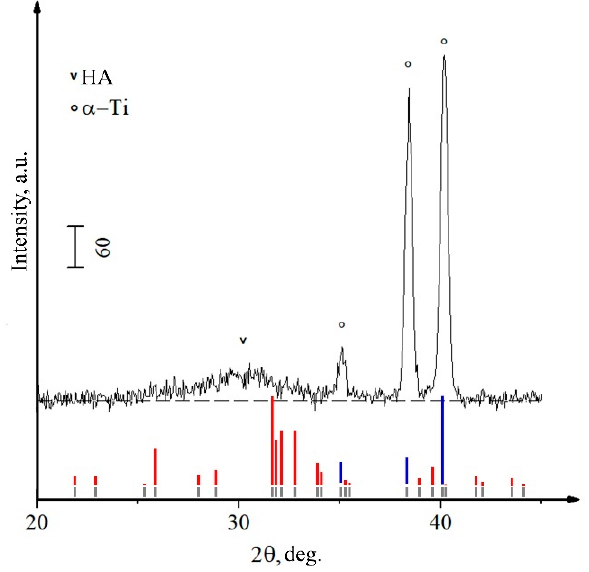
Figure 11. XRD pattern of the Zn containing CaP coating on the surface of NS Ti (red and gray lines represent Ti etalon XRD-patterns according to PDF-card no. 00-044-1294 HA etalon XRD-pattern according to PDF-card no. 00-009-0432).